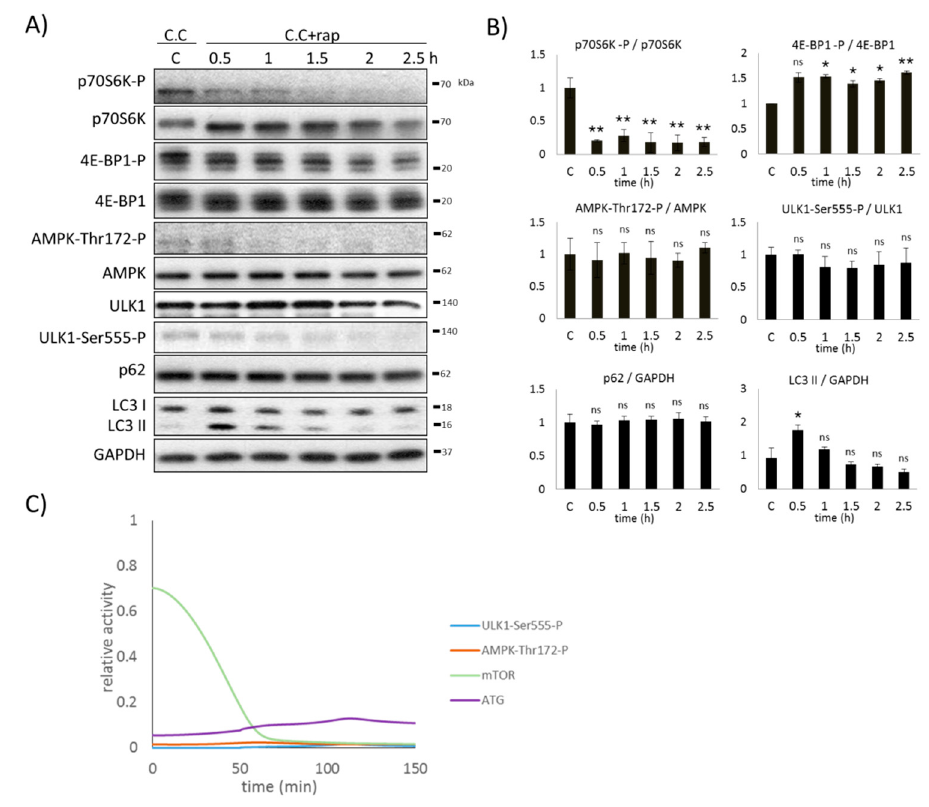
Figure 6. Inhibition of AMPK arrests ULK1 induction upon rapamycin treatment. HEK293T cells were pre-treated with the AMPK inhibitor, Compound C (2 µM, 0.5 h), followed by 100 nM rapamycin treatment in time. ( A ) The markers of autophagy (LC3, p62), AMPK, ULK1 (ULK1-Ser555-P), and mTOR (p70S6K-P, 4E-BP1-P) were followed by immunoblotting. GAPDH was used as the loading control. ( B ) Densitometry data represent the intensity of p62 and LC3 II normalized for GAPDH, ULK1-Ser555-P normalized for the total level of ULK1, p70S6K-P normalized for the total level of p70S6K, 4E-BP1-P normalized for the total level of 4E-BP1, and AMPK-Thr172-P normalized for the total level of AMPK. For each of the experiments, three independent measurements were carried out. Error bars represent standard deviation, asterisks indicate statistically significant difference from the control: ns—nonsignificant; * p < 0.05; ** p < 0.01. ( C ) Computer simulation of rapamycin treatment. The relative activity of AMPK-Thr172-P, mTOR, ULK1-Ser555-P, and autophagy (ATG) are plotted in time.